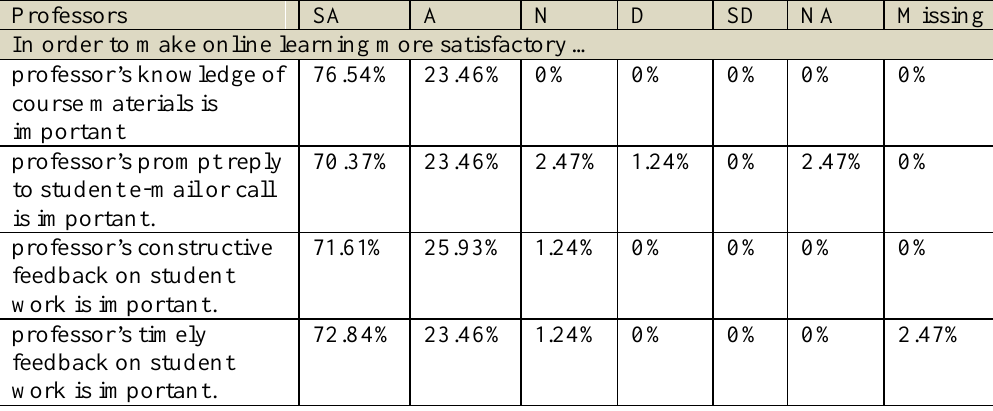
Participants’ Satisfaction Levels Associated with